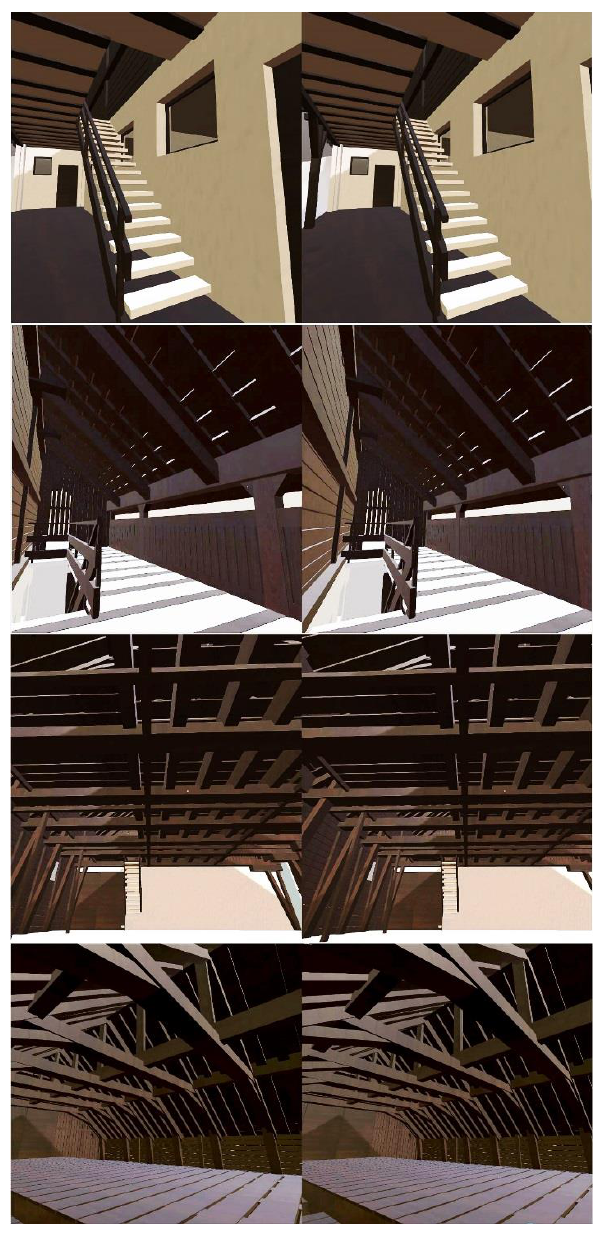
Figure 7: Internal views of the farmhouse in